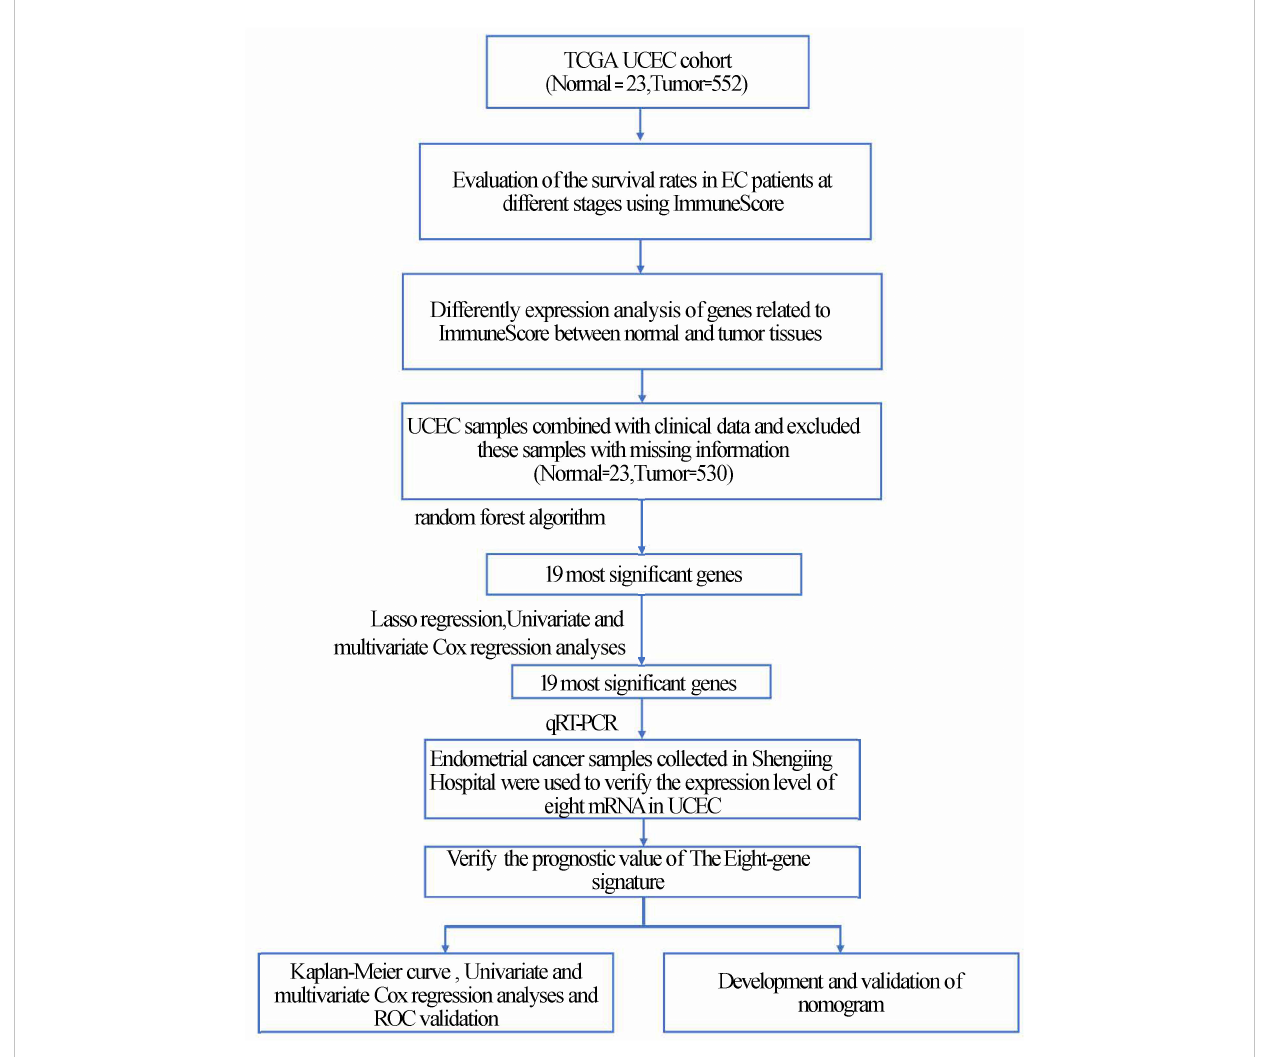
FIGURE 1 Flowchart of the